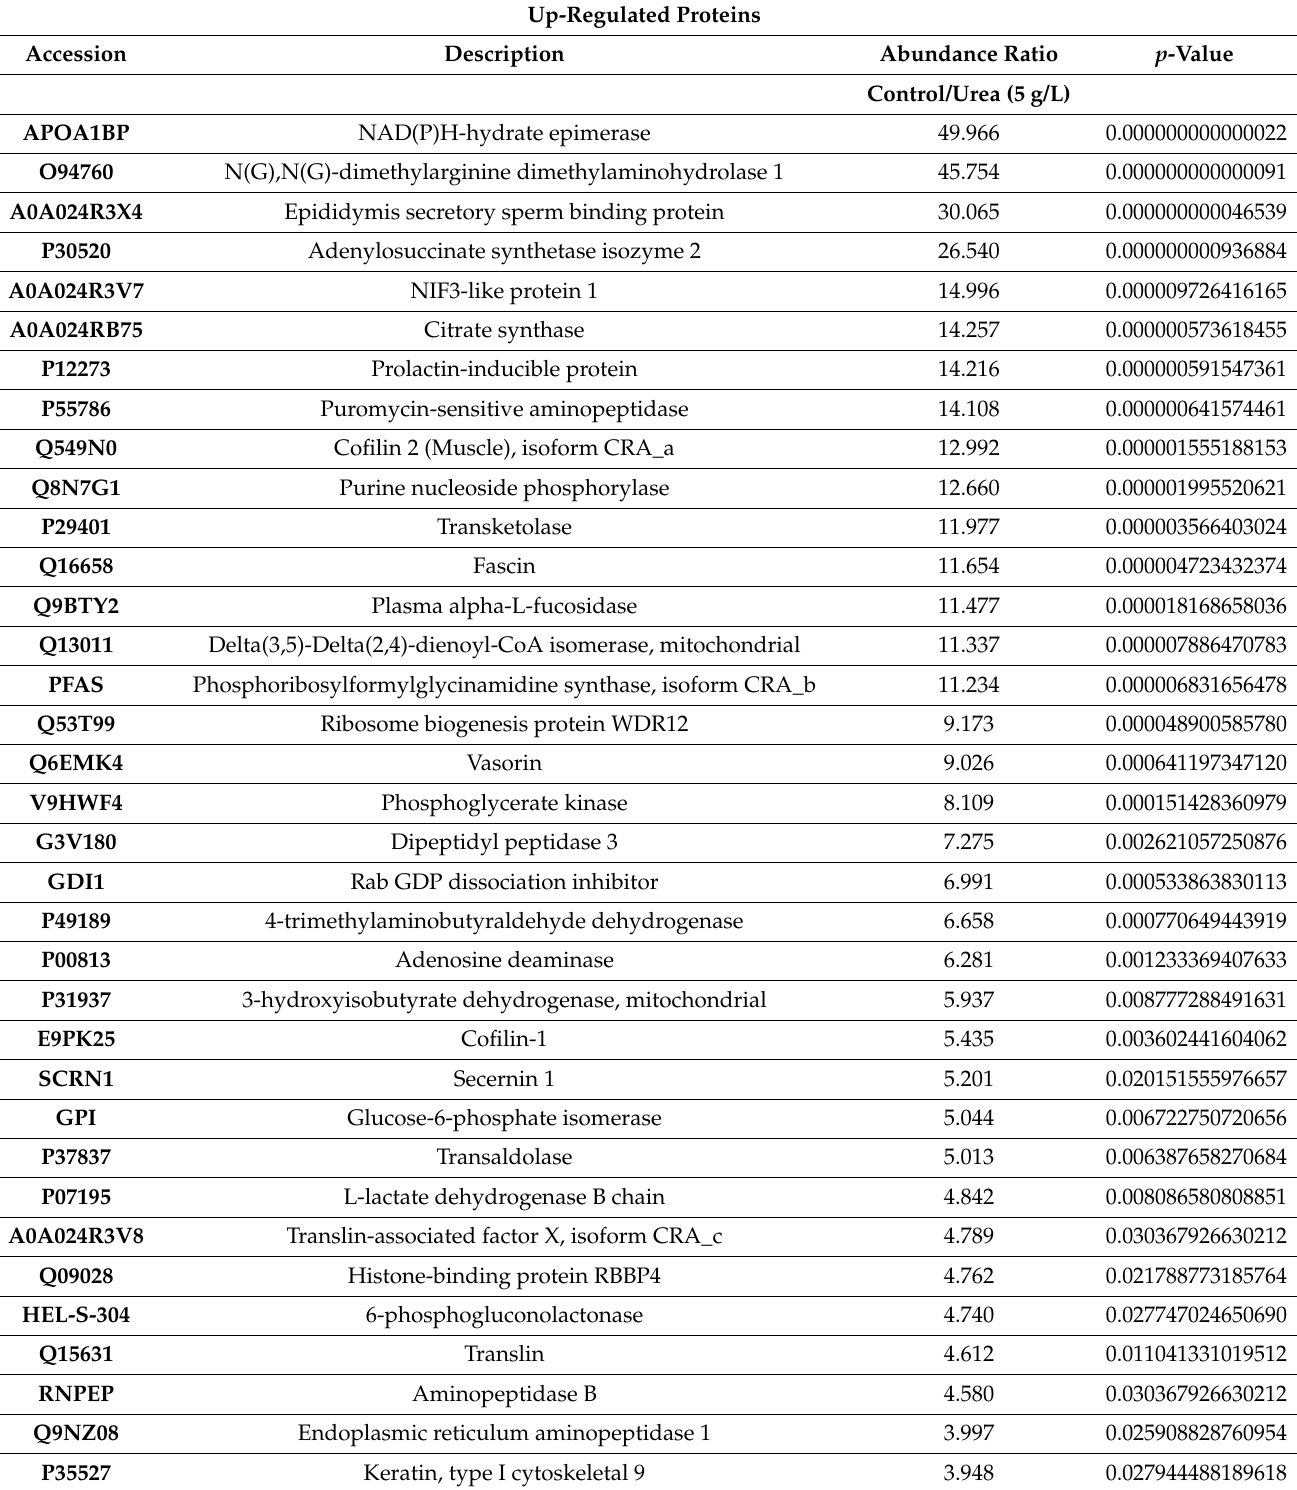
Table 2. Differentially expressed (modulated) secreted proteins following exposure of HMEC-1 to urea. Up-Regulated